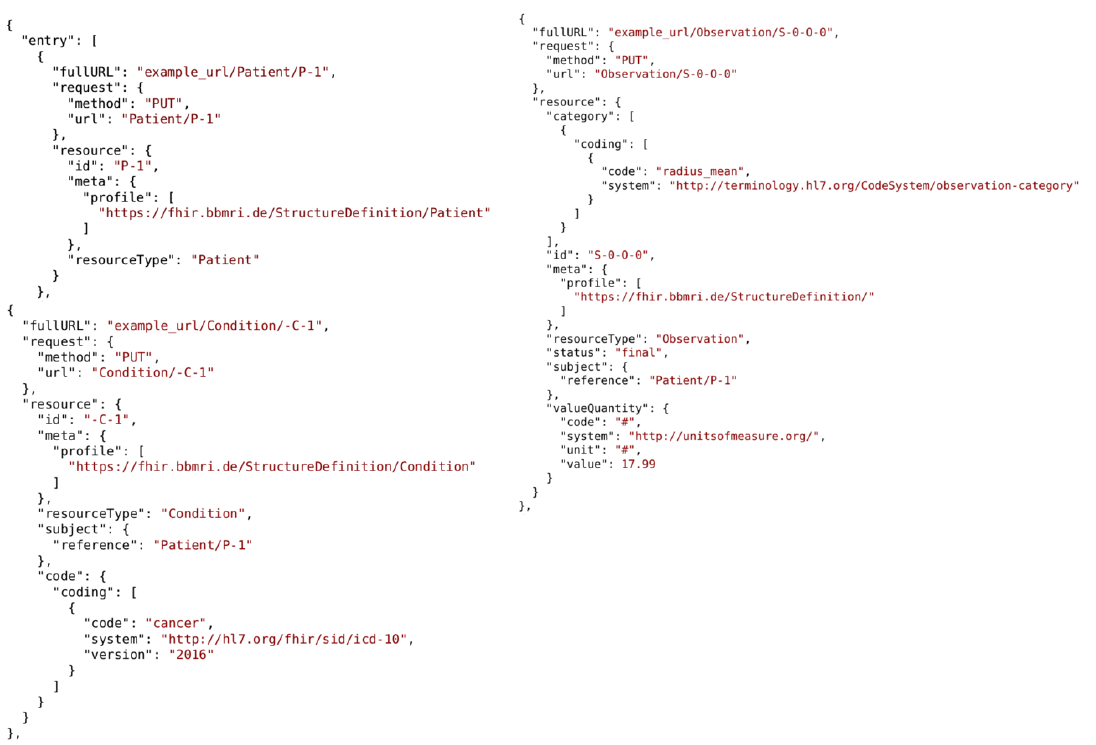
Figure 6. Mapping data from Diagnostic Wisconsin Breast Cancer Database into FHIR resources (i.e., Patient, Observation and Condition). For each record, the features describing characteristics of the cell nuclei are written into the Observation and the diagnosis is written into Condition . Both are referring to a Patient .